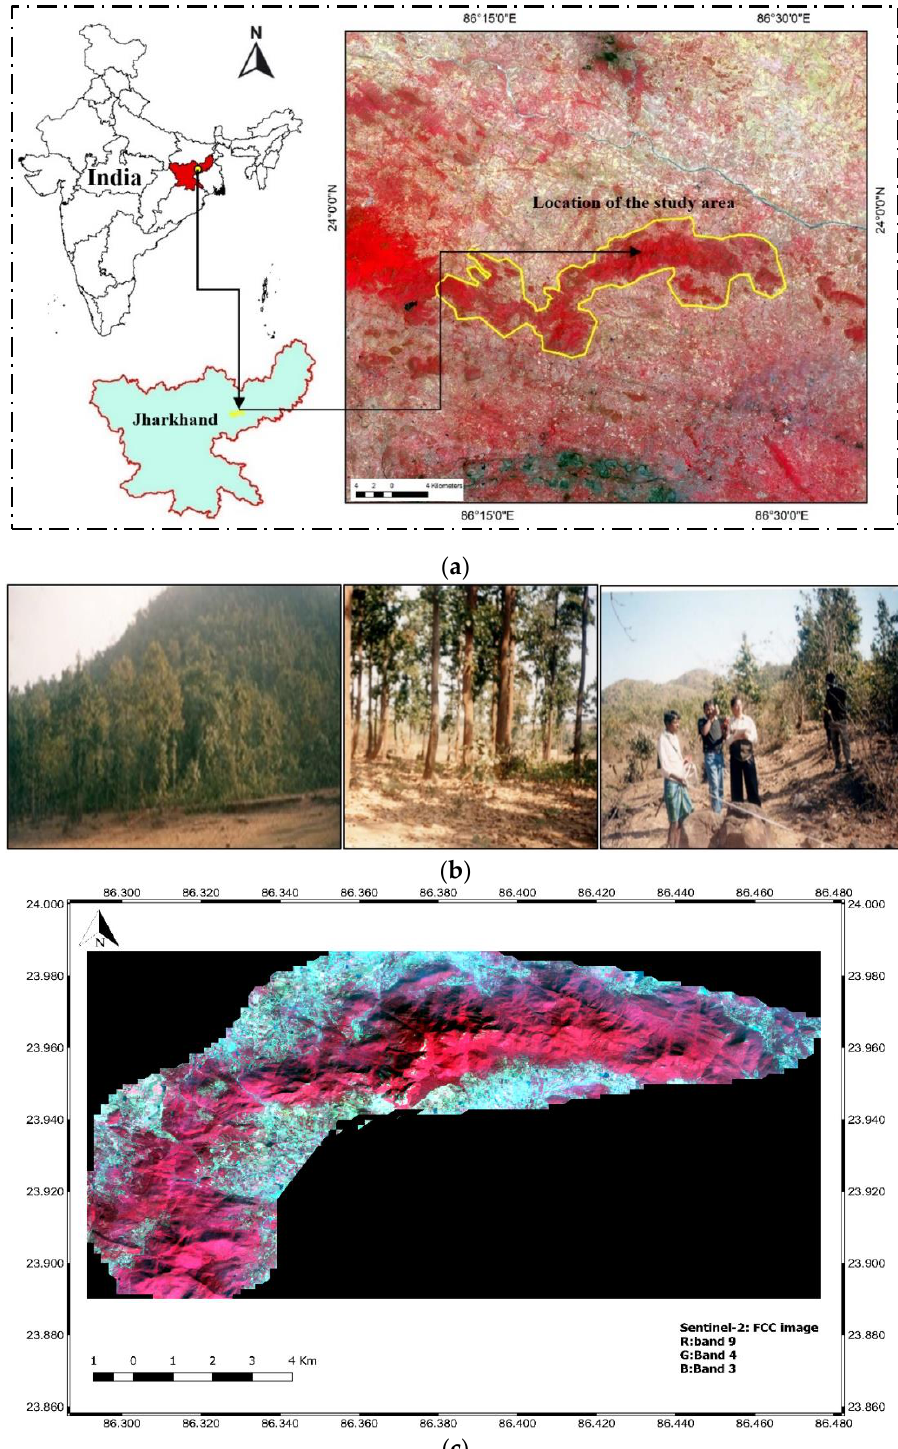
Figure 1. ( a ) Geographic location, ( b ) field photographs, ( c ) false-color composite ( FCC ) image from Sentinel-2 of the study area.